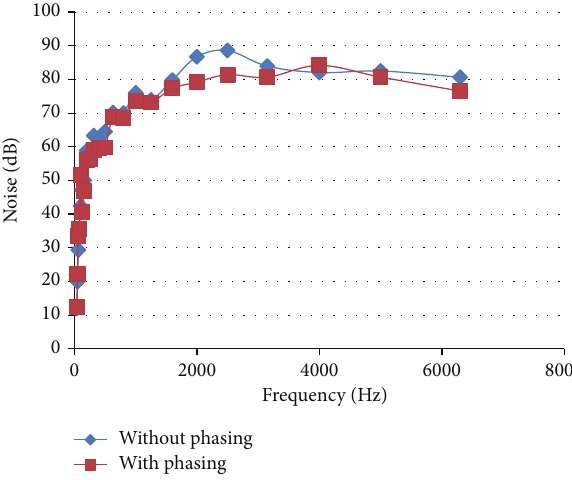
Figure 14: Variation of noise (dB) with frequency (Hz) at 1200rpm at 3 kg load.